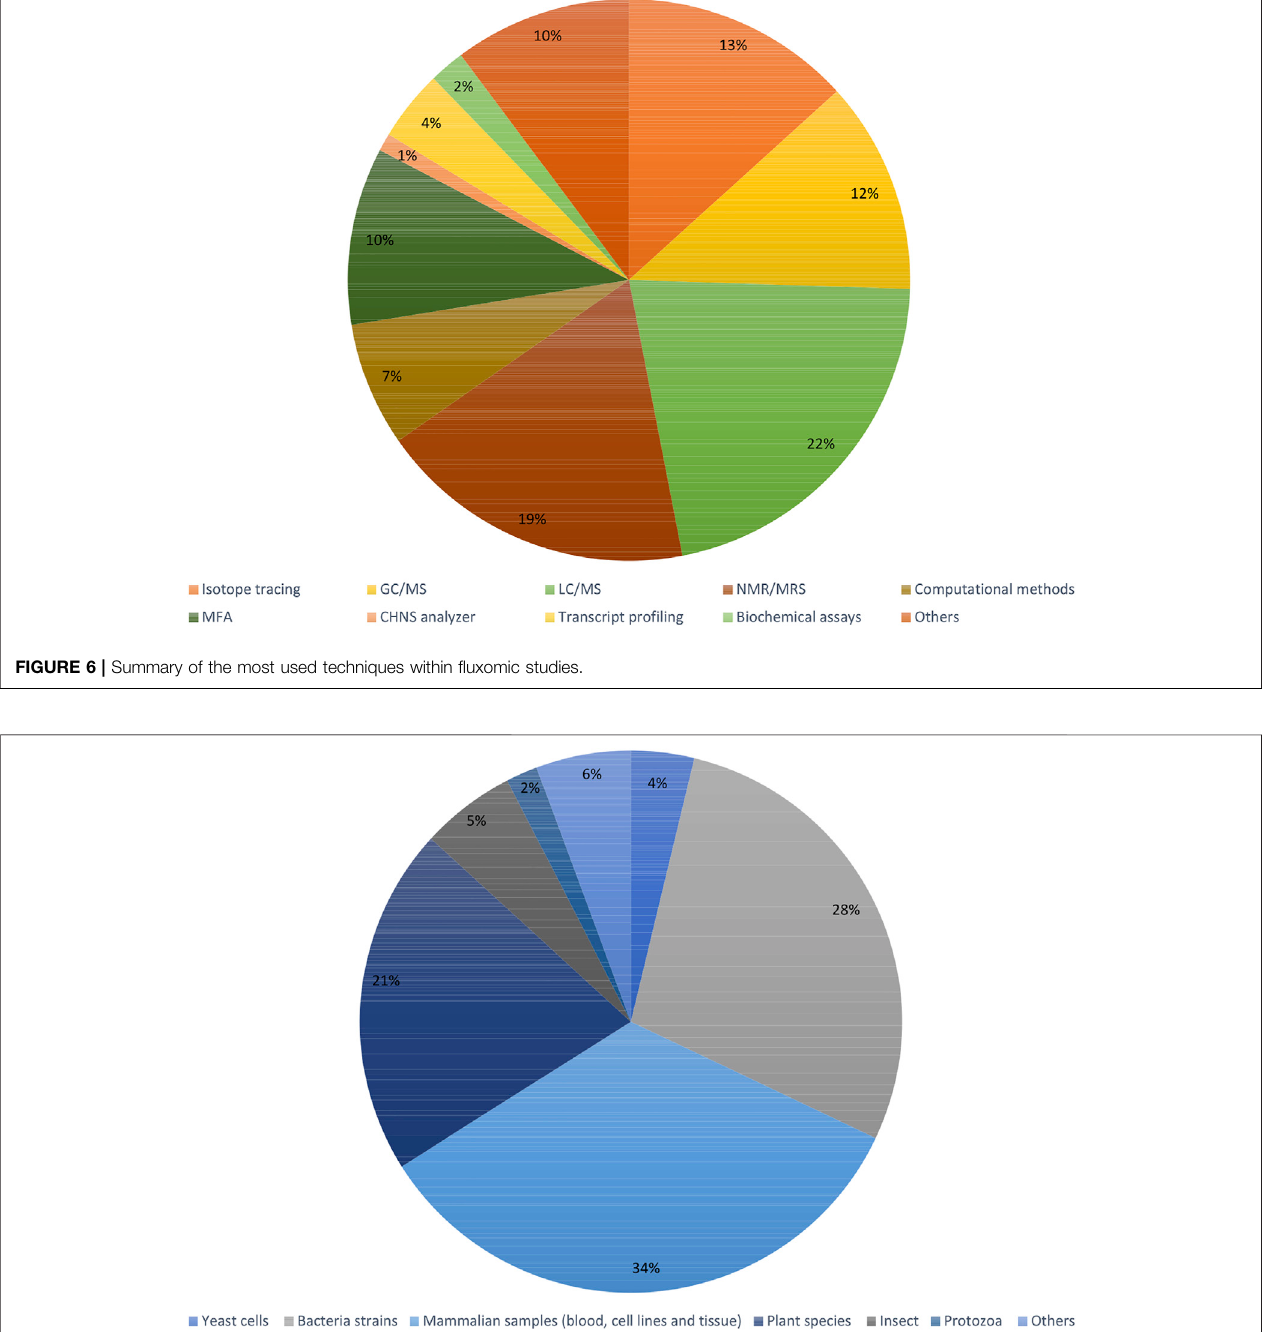
Frontiers in Pharmacology |